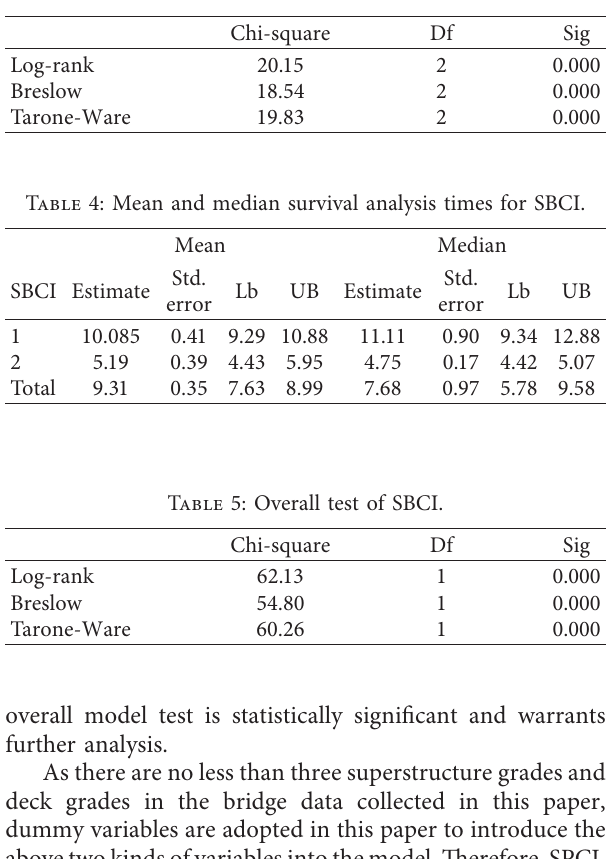
Table 3: Overall test of SPCI.